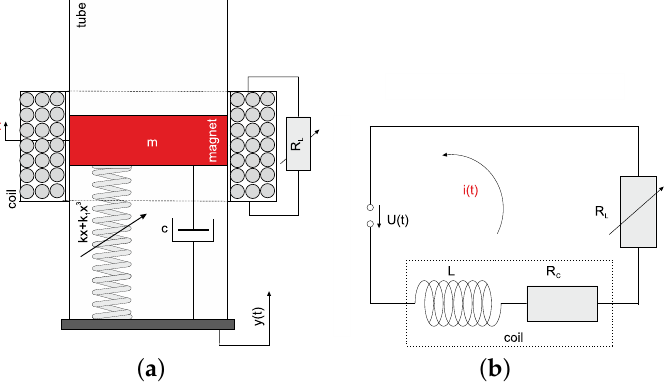
Figure 3. Photo ( a ) and scheme of the single pseudo-levitating harvester ( b ). This system was originally designed and applied as the pendulum tuned mass damper (see paper [31]).